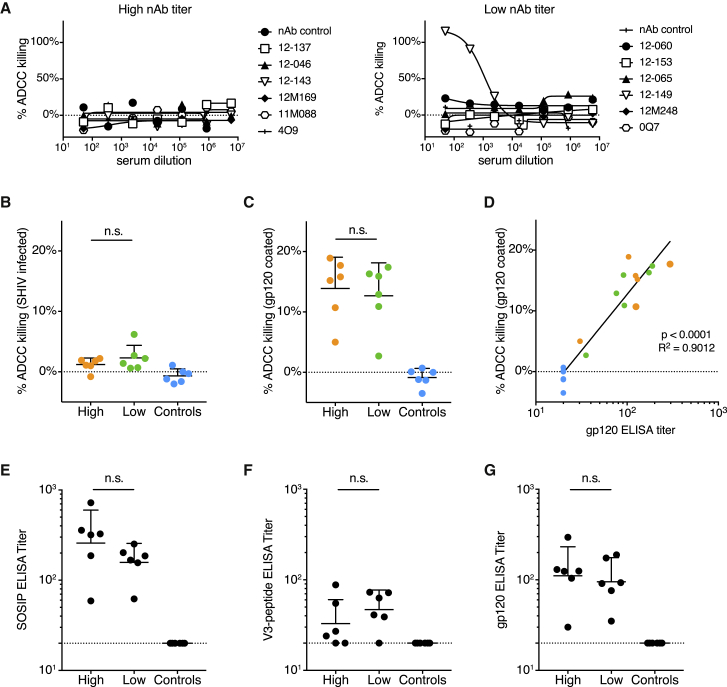
ADCC Activity at Week 0 Measured in SHIV Infection as well as gp120-Based Assays Is Not Associated with the Observed Protection from Infection(A–D) ADCC activity from sera of high and low nAb titer as well as control animals at week 0. ADCC activity in titrated sera was measured using SHIVBG505 challenge stock infected CEM.NKR luciferase-reporter target cells and CD16 transfected KHYG-1 effector cells (A) or in 1:250 diluted sera by flow cytometric analysis of ADCC activity in either p27+ SHIVBG505-infected CEM.NKR cells (B) or BG505 g120-coated CEM.NKR cells (C), using PBMCs as effector cells. Shown are means with standard deviations. ADCC activity in BG505 gp120-coated CEM.NKR cells correlated with BG505 gp120 binding titers (D).(E–G) ELISA EC50 binding titers at week 0 to: BG505 SOSIP.664 (E), BG505 V3-peptide (F), or BG505 gp120 (G). Sera from high and low nAb titer animals, as well as unimmunized control animals were tested for ELISA binding titers at week 0. Shown are geometric mean titers with geometric standard deviations. Correlations were calculated using Spearman correlation tests, comparisons between groups were calculated using two-tailed Mann-Whitney U tests.See also Figure S7.